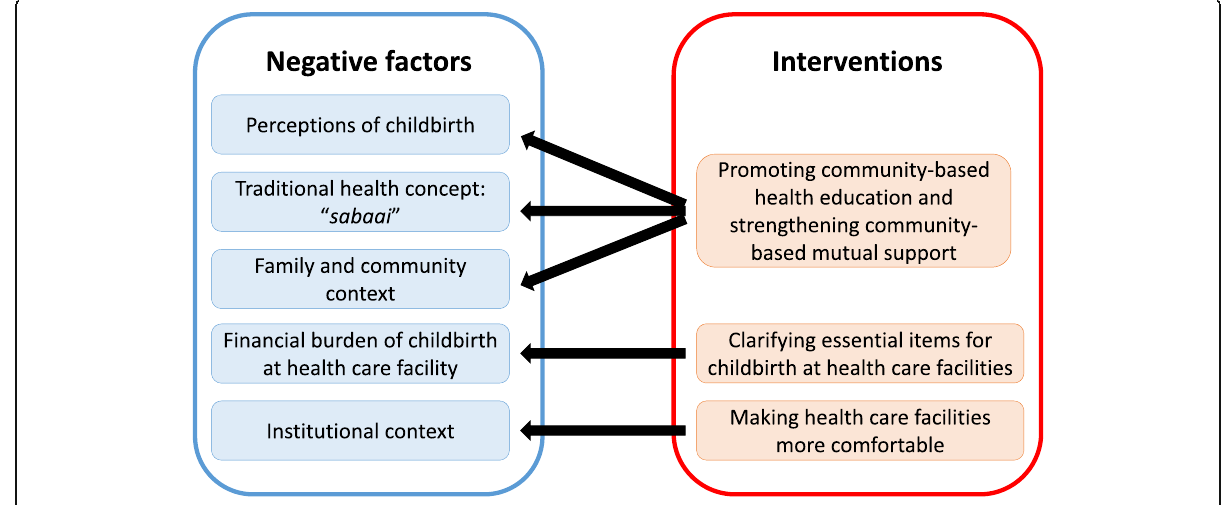
Fig. 1 Intervention to mitigate negative factors influencing the choice of facility-based